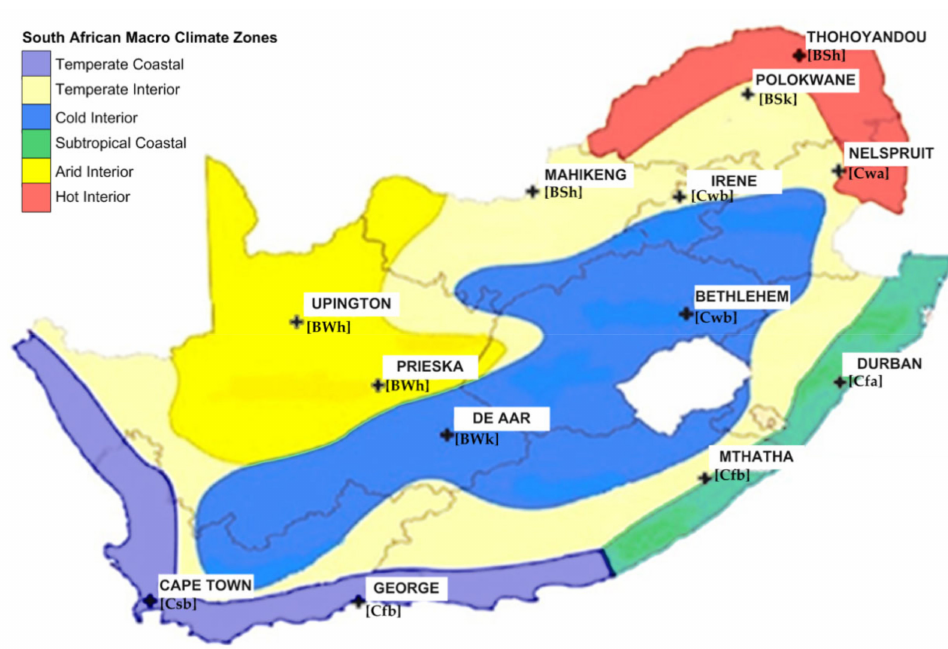
Figure 1. A map showing the location of the South African Weather Service’s radiometric station, SAWS macro climate zones, and with CSIR Köppen–Geiger “micro” climate in square brackets (Adapted from